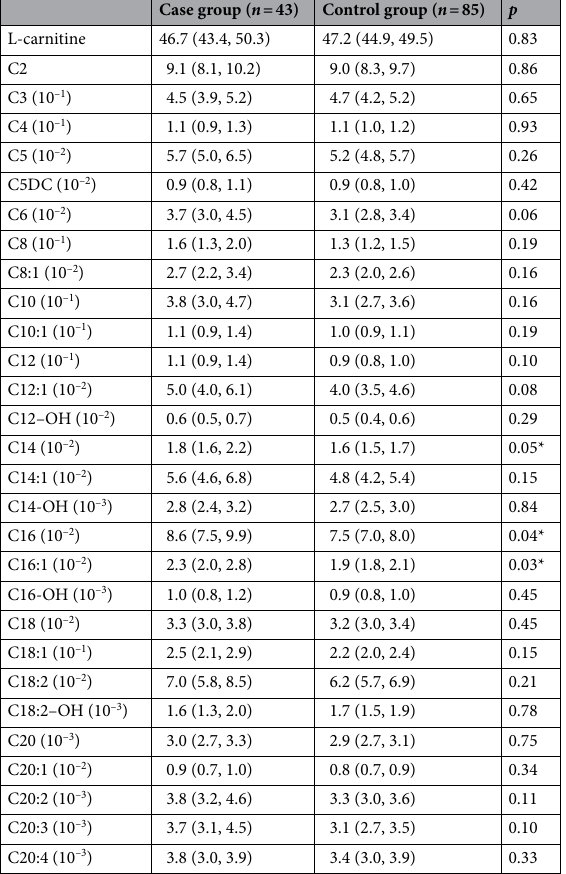
Table 2. Geometric means (95% confidence interval) of L-carnitine and acylcarnitines levels (µM) in case and control groups. p values were calculated with an unpaired t-test over the log-transformed L-carnitine and acylcarnitines values. * p <